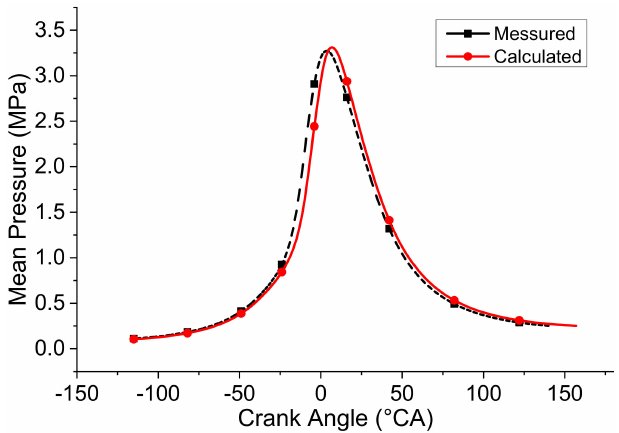
Figure 2. Data comparisons to a hydrogen engine